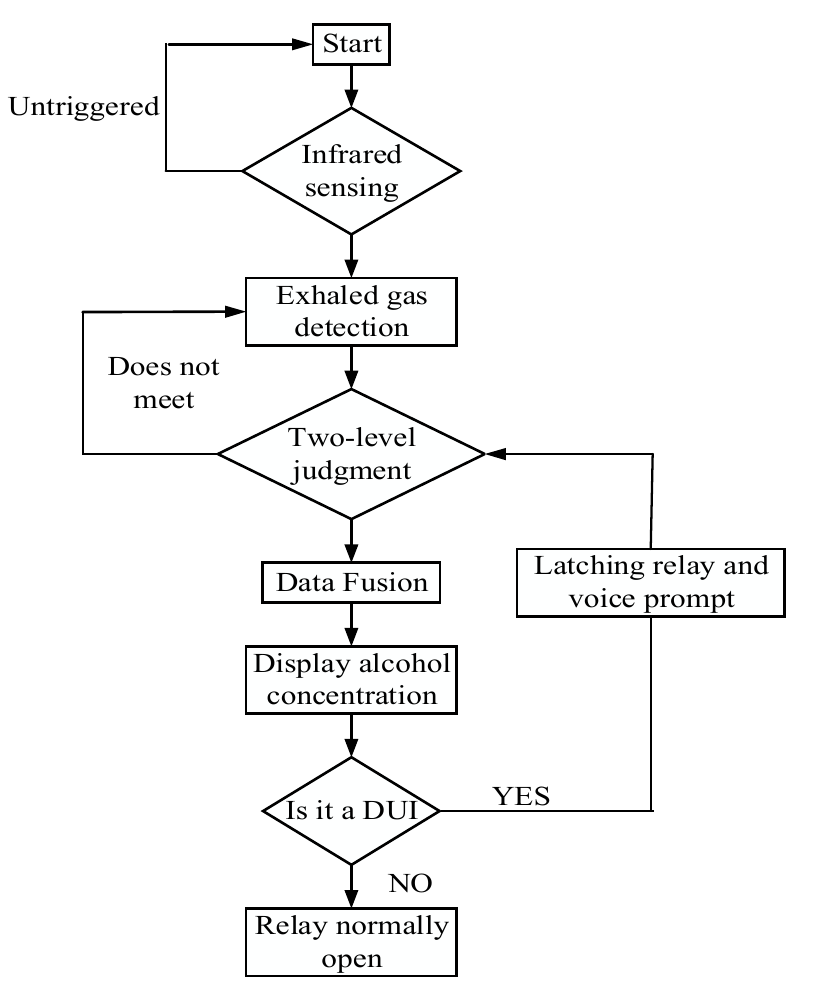
Figure 5. Device program flow.